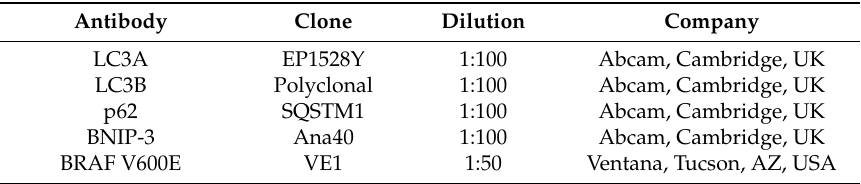
Table 7. Sources, clones, and dilutions of antibodies used for